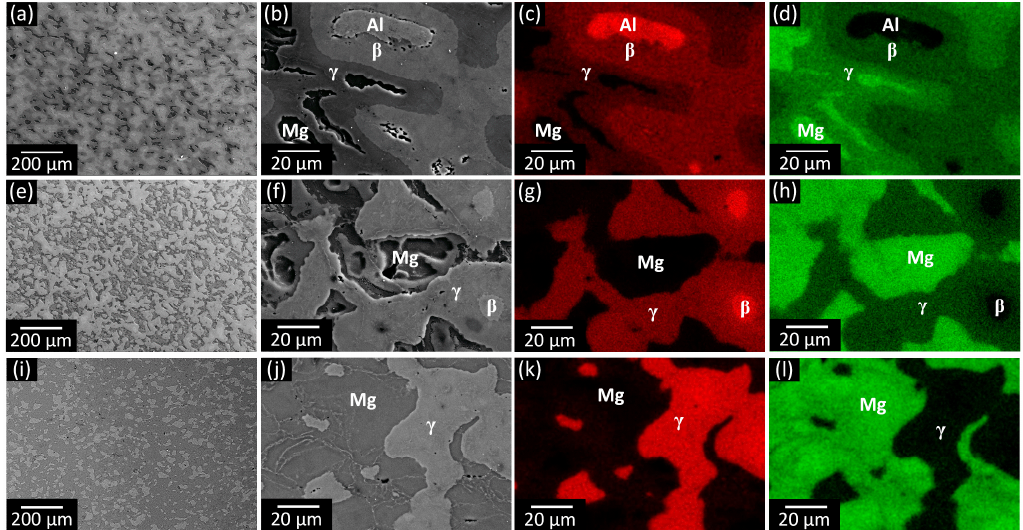
Figure 3. The SEM images and EDX elemental maps of the Al (red) and Mg (green) distributions for the Al ‐ Mg composites hot ‐ pressed at 673 K with an initial Mg content of ( a – d ) 60, ( e – h ) 80 and ( i – l ) 90 vol %.